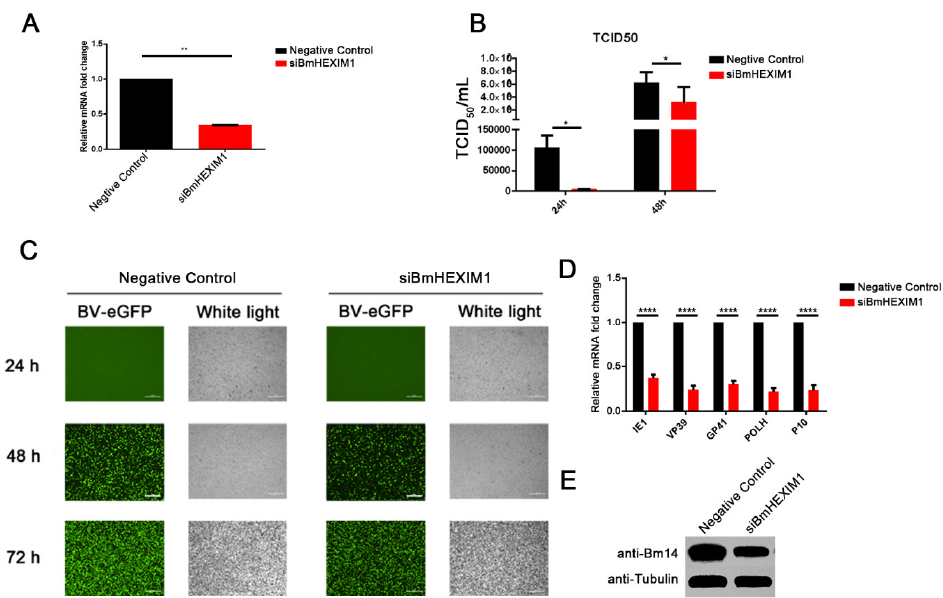
Figure 2. RNAi down-regulated BmHEXIM1 and inhibited the invasion of BmNPV. ( A ) The RNAi of the siBmHEXIM1 RNA decreases the expression level of protein HEXIM1 at 48 h post-transfection. ( B ) TCID 50 end-point dilution was used to evaluate the production of infectious BV at 24 h and 48 h. ( C ) The infected cells (the cells with the green fluorescence) were observed by an inverted fluorescence microscope at 24 h and 48 h (bar = 100 µ m). ( D ) BmN cells were transfected with si-NC and siBmHEXIM1 RNA for 48 h. Then, the cells were infected with BmNPV for 48 h. The viral gene’s expression was measured by qRT-PCR analysis. ( E ) The BmNPV abundance was assessed by analyzing the expression of Bm14 by Western blot after knockdown of BmHEXIM1. The mRNA level of target genes was normalized to the internal control (BmRPL32). Data represent mean ± SEM of the three independent experiments. The number of asterisks represents the degree of significance with respect to p -value. p -values were provided as * p < 0.05; ** p < 0.01; **** p <